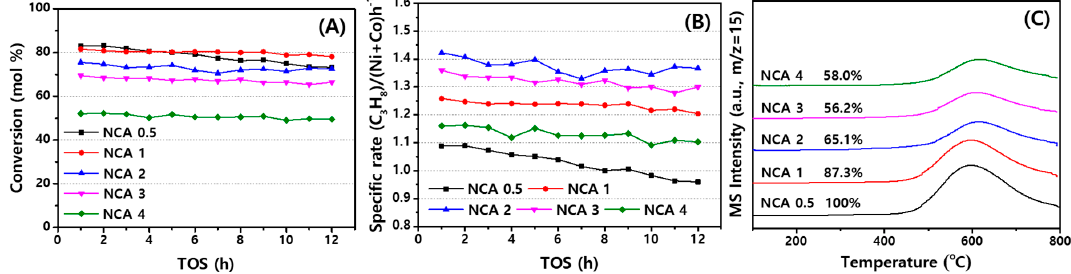
Figure 3. Catalytic activities of the NCA catalysts for ( A ) C 3 H 8 conversion, ( B ) specific rate of C 3 H 8